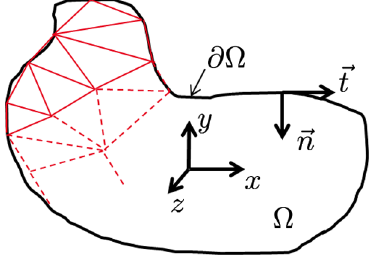
FIG. 1. Computational domain for the 2D impedance solver.